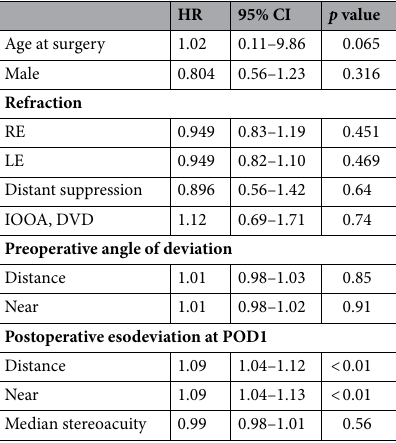
Table 4. Weighted Cox’s proportional hazard model regression analysis based on period of exodrift after surgery. RE right eye, LE left eye, IOOA inferiorobliqueoveraction, DVD dissociated vertical deviation, POD postoperative